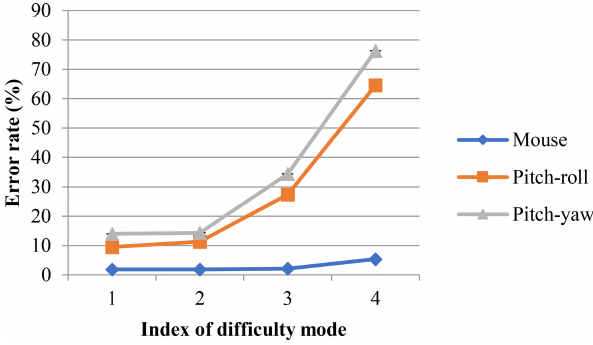
Figure 6. Error rate as a function of index of difficulty